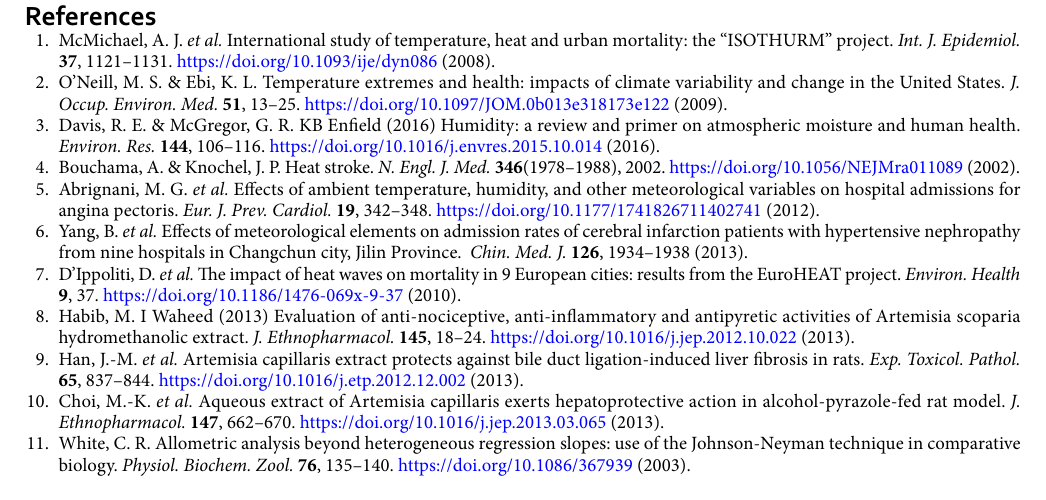
high-quality, clean tags according to the Fast QC (V 0.10.1) 49 . Chimeric sequences were filtered using Useach software (10 version). Sequences with 97% similarity were assigned to the same operational taxonomic units (OTUs) by Usearch (10 version). Representative sequences were chosen for each OTU, and taxonomic data were then assigned to each representative sequence using the RDP (Ribosomal Database Project) classifier. Sequences were processed with the software package of the QIIME (V1.9.0) 50 toolkit. Taxonomy-based analy- ses were conducted by classifying each sequence using the SILVA database (https ://www.arb-silva .de/). Alpha diversity, beta diversity, and rarefaction curve analyses were performed based on the relative OTU abundance table. Alpha diversity including Chao1, Shannon, Simpson, and Observed species, which was analyzed using Mothur. Principal coordinate analysis (PCoA) was performed using R software (R 3.4.2) and linear discriminant analysis (LDA) coupled with effect size measurement (LefSe) analysis was conducted online (http://hutte nhowe r.sph.harva rd.edu/galax y/). The original data collected by LC–MS/MS were processed by XCMS Online (https ://xcmso nline .scrip ps.edu) 51 , which can provide a comprehensive method of data processing, including retention time correction and peak alignment. After the data pre-processing, the dataset was generated consisting of the m/z value, reten- tion time, and the related peak areas and was imported into SIMCA-P software (14.1 Version, Umetrics AB, Sweden) for multivariate statistical analysis (PCA analysis, PLS-DA analysis, OPLS-DA). By using a combination of multivariate statistical analysis of OPLS-DA and univariate statistical analysis, differential metabolites were screened(VIP > 1, p < 005). Semi-quantitative analysis (heat map) and cluster analysis of potential biomarkers by Mev (version 4.9.0) software were performed. Finally, the metabolic pathway databases such as KEGG (http:// www.genom e.jp/kegg/) 52 were used to perform enrichment analysis and network construction of related meta- bolic pathways. The raw LC–MS/MS data were analyzed using the Multiquant Software to obtain calibration equations and the quantitative concentration of each BA in the samples. Differences in the BA measurements between the groups were analyzed using a Student’s t-test with p < 0.05 considered significant. The regression equation was derived from the standard curve, the relative deviation of the samples’ lower limit of quantification (LLOQ) was ≤ 20%, the relative deviation of the other concentrations and quality control relative standard deviation (QC RSD) was ≤ 30% and the square of the correlation coefficient R was > 0.99. The content of each test sample was calculated from the standard curve. Spearman correlation analysis was used to analyze the correlation between fecal microflora and metabolomics. Using R software (version 3.3.1) to generate graphics, we get the results with p < 0.05, which are statistically significant. One-way ANOVA was performed using the Social Science statistics Software Package (SPSS 22.0, Chicago, USA). The significance threshold of this experiment was p < 0.05. All statistical tests were performed using Graphpad Prism, version 8.0. Ethical